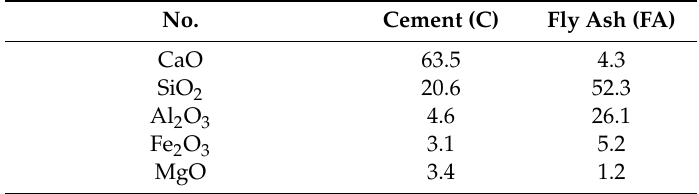
Table 1. Chemical and physical properties of cement (C) and fly ash (FA).